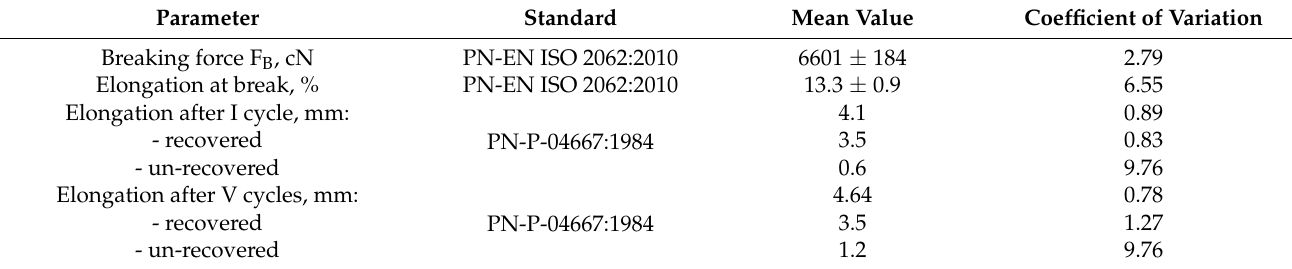
Table 2. The tensile test results for used yarn.